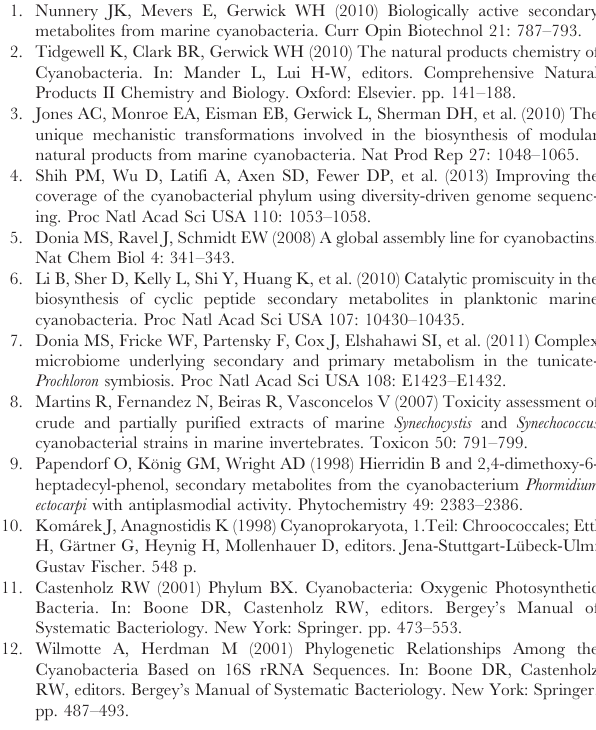
Figure S1 1 H NMR spectrum (500 MHz, CDCl 3 ) of hierridin B (1). Insert shows comparison with previously reported 1 H NMR data (300 MHz, CDCl 3 ) for the compound (TIF) Figure S2 Cytotoxicity dose-response curve of HT-29 cells exposed to hierridin B (1) (IC 50 = 100.2 m